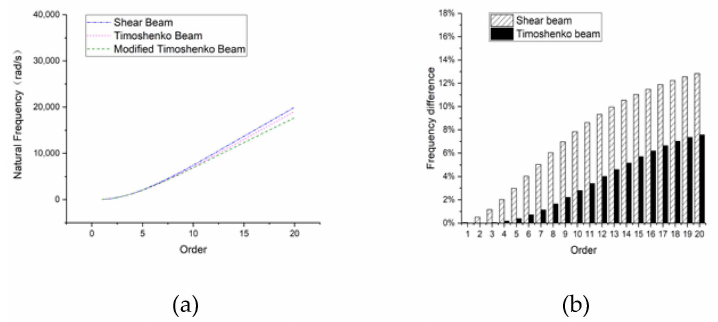
Figure 10. Natural frequencies of the 8-m-long beam: ( a ) overall frequency curve and ( b ) frequency di ff erence compared with a modified Timoshenko beam.